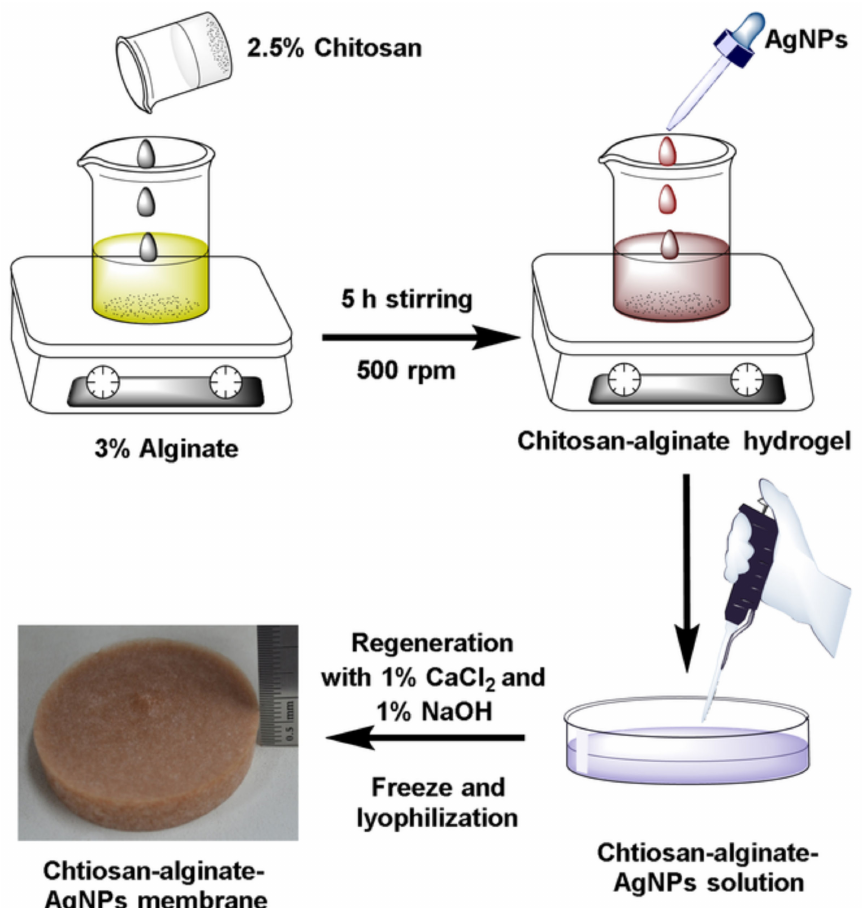
Figure 19. Chitosan–alginate membrane preparation process. Reprinted from [46].Copyright 2017 with permission from